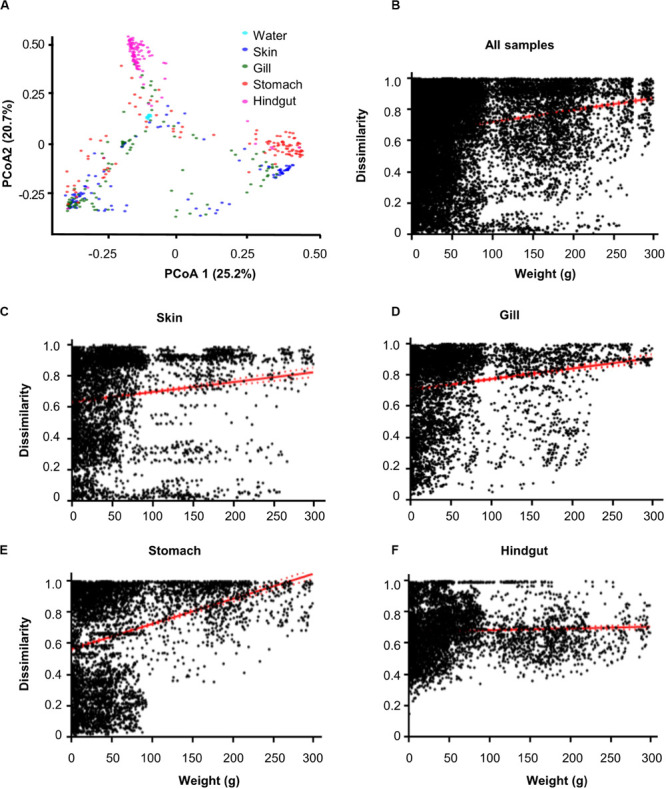
Dissimilarity of microbial communities in different body habitats and its correlations with body weight. (A) Principal coordinated analysis (PCoA) based on Bray–Curtis distance. Community dissimilarities significantly (p < 0.05) increased as body weigh difference in (B) all samples, (C) skin, (D) gill, (E) stomach, and (F) hindgut. Solid lines show linear regressions; dotted lines show 95% confidence interval of regression lines. The p-value was calculated by comparing the observed F-value with those from 1,000 randomized data sets.